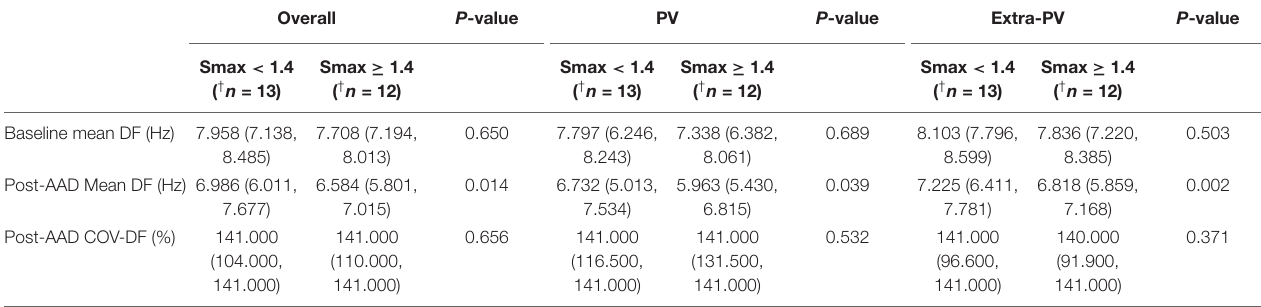
TABLE 3 | Atrial fibrillation (AF) wave-dynamics depending on the Smax values. Overall P -value PV P -value Extra-PV P -value